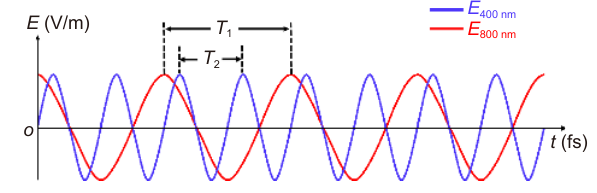
Fig. 5 | Schematic diagram of the electric fields of the two-color laser beams.